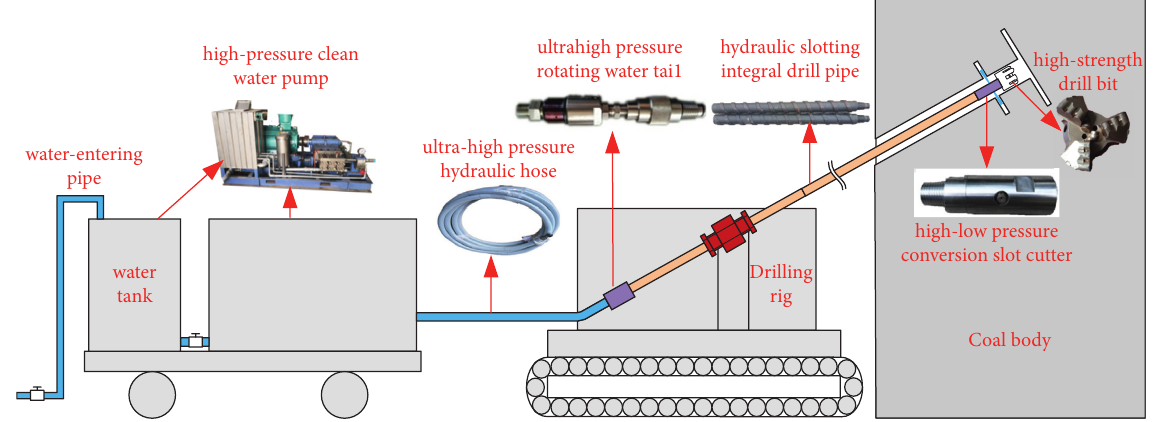
Figure 19: Ultrahigh-pressure hydraulic slotting device.